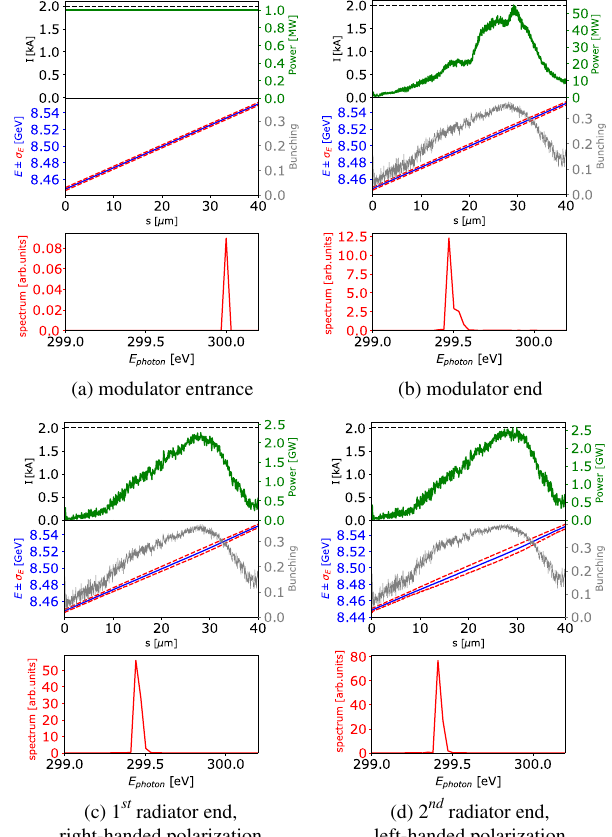
FIG. 7. Properties of electron beam and FEL radiation at different locations along the undulator. Top subplots depict the electron beam current (black dached line, 2 kA constant), and radiation power (green solid line). Middle subplots depict mean (blue line) and 2 σ spread (red dashed lines) of the electron beam energy as well as its bunching (grey line). Bottom plots show the on-axis spectra of the